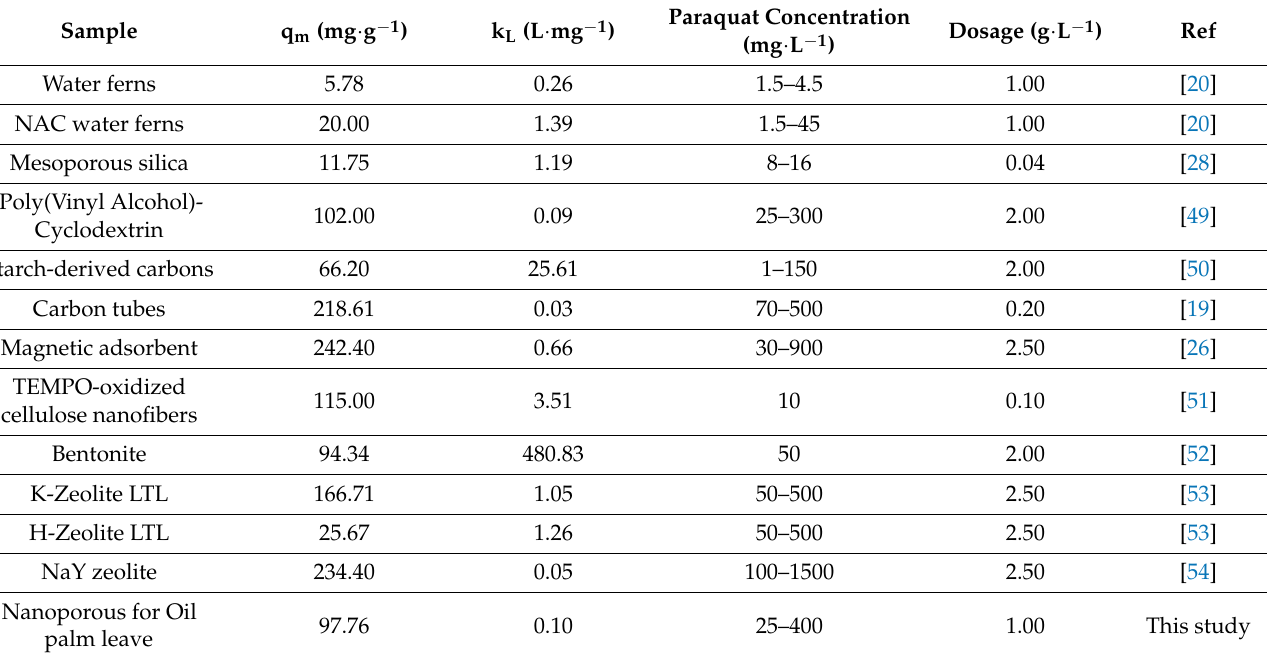
Table 8. Comparison of q m , k L , concentration and dosage values from the Langmuir isotherm model of adsorbents and modified adsorbents for the removal of